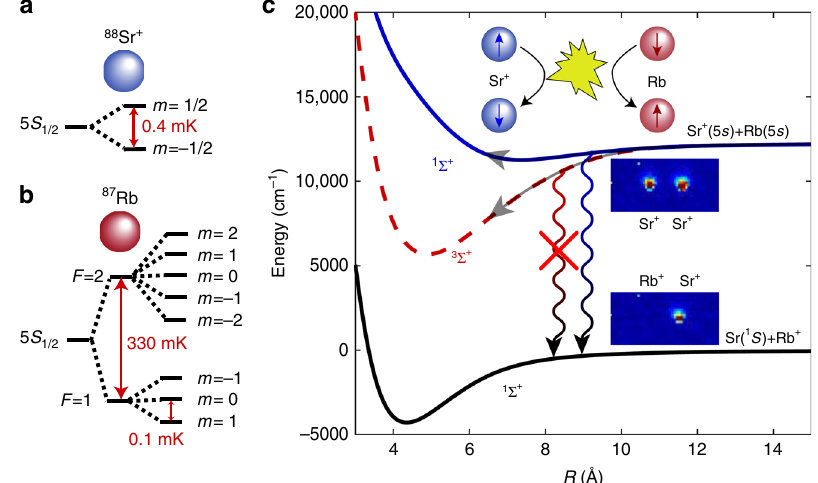
Fig. 1 Energy levels diagrams. a , b Level structure of the 88 Sr + electronic ground state and hyper fi ne structure of the 87 Rb. The Zeeman splitting is for B = 3 G. c Pictorial representation of potential energy curves of the (RbSr) + complex. The experimental entrance channel (Sr + (5 s ) + Rb(5 s )) is not the absolute ground state of the system which allows for radiative charge-exchange processes (curly lines). During a collision, the atomic asymptotic state (Sr + (5 s ) + Rb (5 s )) splits into a superposition of singlet ( 1 Σ + , blue solid line) and triplet ( 3 Σ + , red dashed line) states. Only radiative charge exchange from the singlet state is allowed (blue curly line), as the molecular ground state of the system (Sr( 1 S ) + Rb + ) is also a singlet state ( 1 Σ + , solid black line). A pictorial representation of spin-exchange collision is also